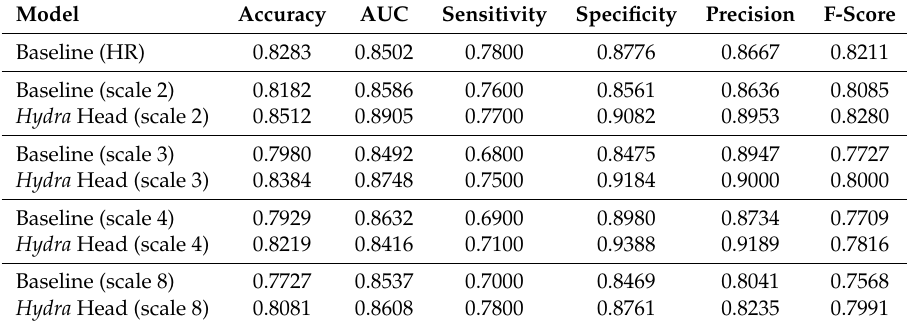
Table 2. Performance of CXR abnormality classification using the baseline model and Hydra